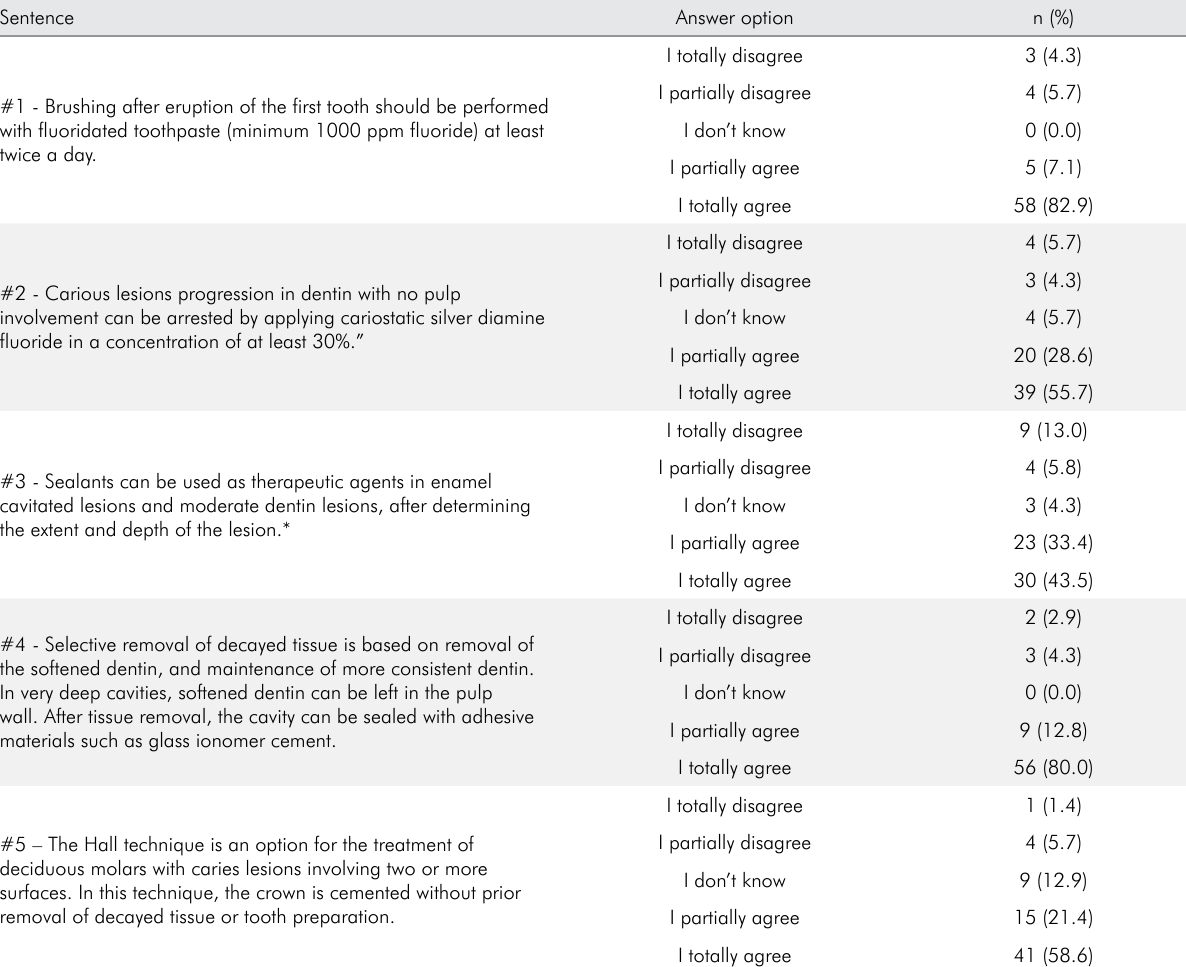
Table 2. Sentences and answers.